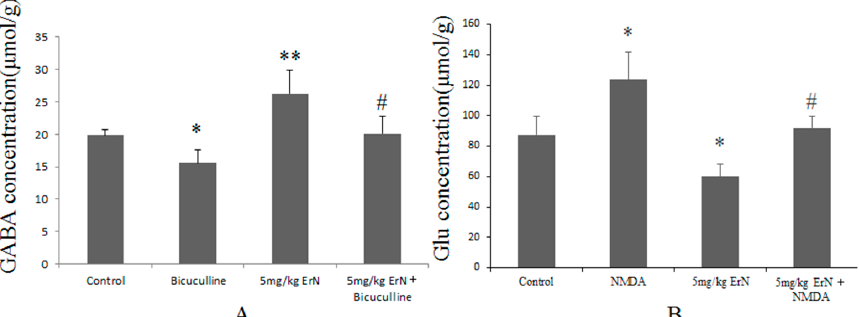
Figure 4. Effects of ErN, bicuculline, NMDA and co-treatment on the GABA ( A ) and Glu ( B ) levels in the brains of mice exposed to the FST. The values represent the mean ± SD ( n = 10 in each group), compared with control group, * p < 0.05, ** p < 0.01; compared with ErN (5 mg/kg) group, # p < 0.05. One way ANOVA, post-hoc Tukey test.